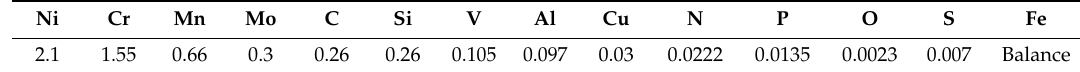
Table 1. Chemical compositions of 25CrNi2MoVE steel samples (wt. / %).